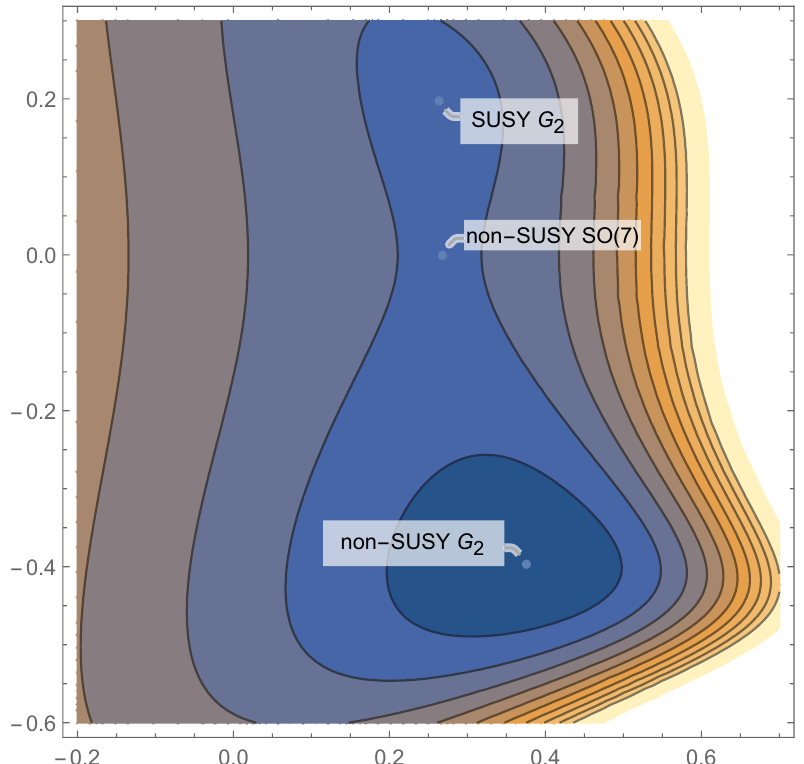
Figure 1. The level curves of the scalar potential for the G 2 -invariant sector of ISO ( 7 ) gauged supergravity. The horizontal axis represents the ϕ direction, while the vertical axis represents χ . Both the SUSY and non-SUSY G 2 extrema are local minima, while the SO ( 7 ) critical point is actually a